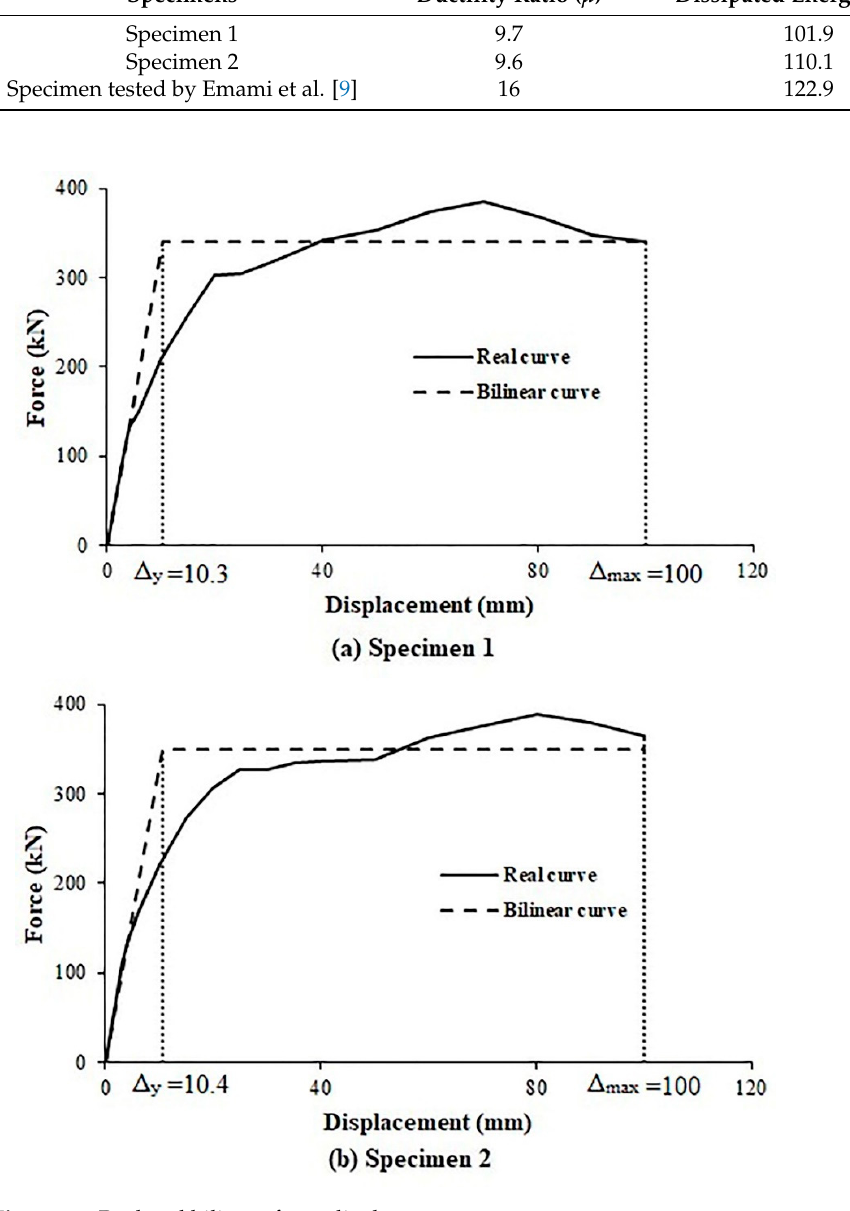
Table 2. Ductility ratio and dissipated energy during cycles with displacements of 70 and 80 mm.